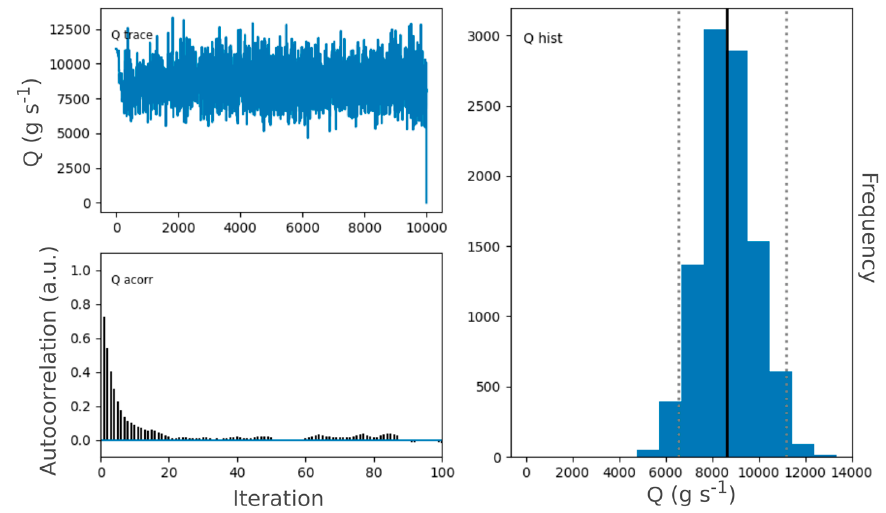
Figure 8. Inversion result for WD = 130°. Trace of the MCMC sampling for the first 10,000 runs, autocorrelation between samples of the posterior pdf, which is reduced to below 10%, shown here for the first 100 runs and histogram view of the trace (posterior pdf). All units of the flux Q are in g s − 1 .